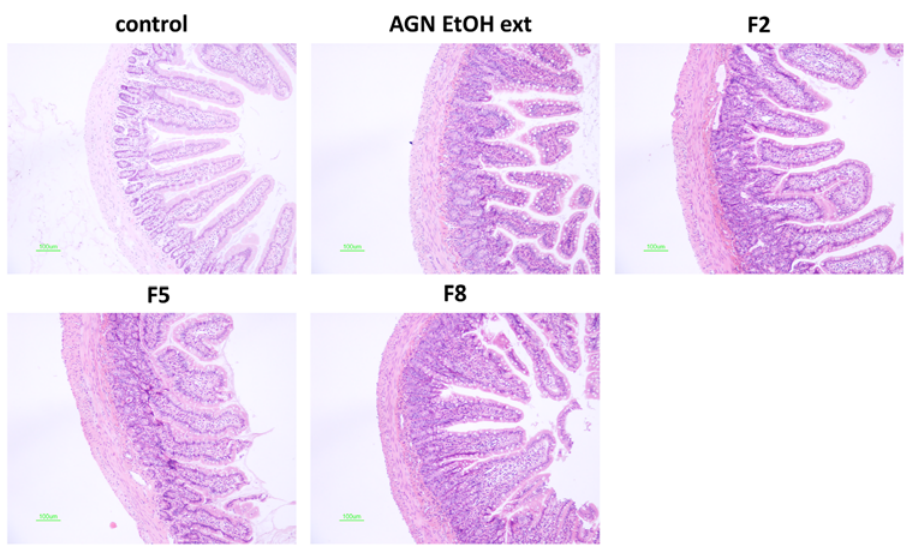
Fig 6. In vivo toxicity test in the intestinal epithelium after oral administration of AGN EtOH ext, F2, F5, and F8 in rats. Jejunum of rat was excised at 24 h post-administration of each formulation orally and the tissue was stained by H&E. The length of scale bar (green color) is 100 μ